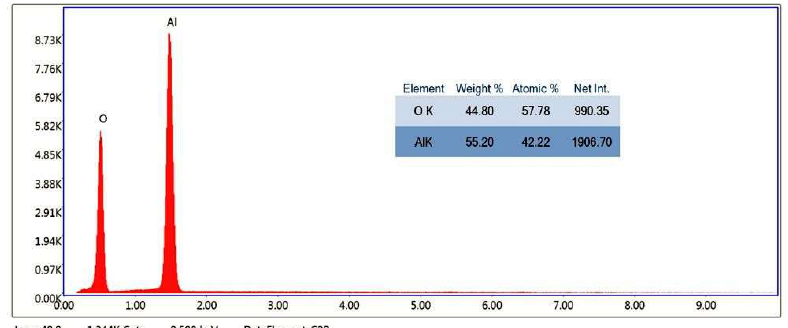
Figure 7. The result of the EDS analysis.